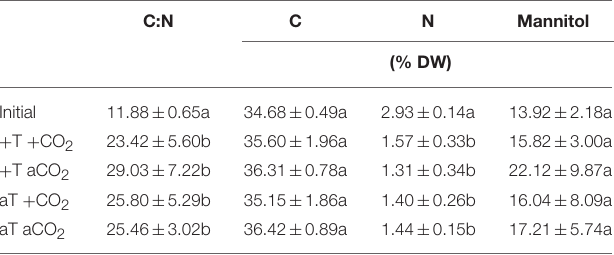
TABLE 1 | Analysis of Fucus mytili tissue: carbon-to-nitrogen (C:N) ratios, C, N, and mannitol